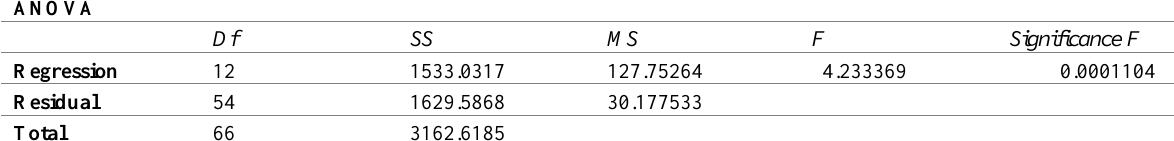
Table 20: ANOVA (Rajshahi Division)